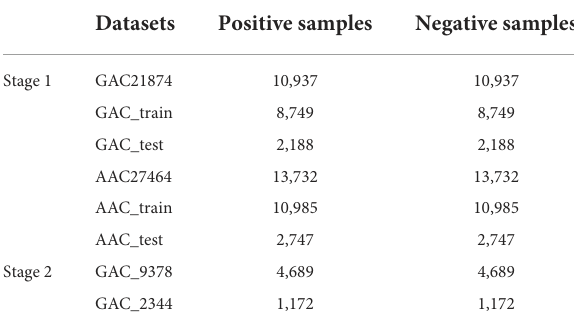
TABLE 1 Benchmark datasets